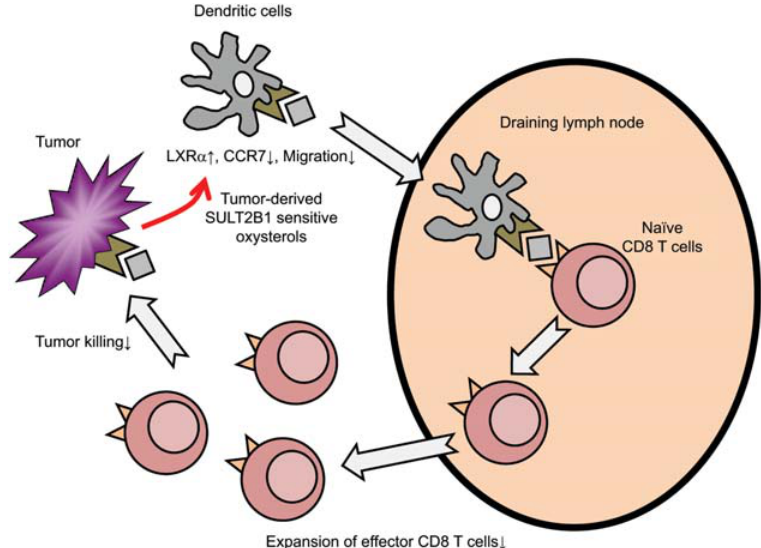
terol 25-hydroxylase in macrophages is upregulated and newly synthesized 25-hydroxycholesterol is released from the cells (35). Importantly, activation of innate immunity could increase de novo synthesis of 25-hydroxycholesterol, which in turn modulates the expression pattern of immuno- globulin isotypes in B